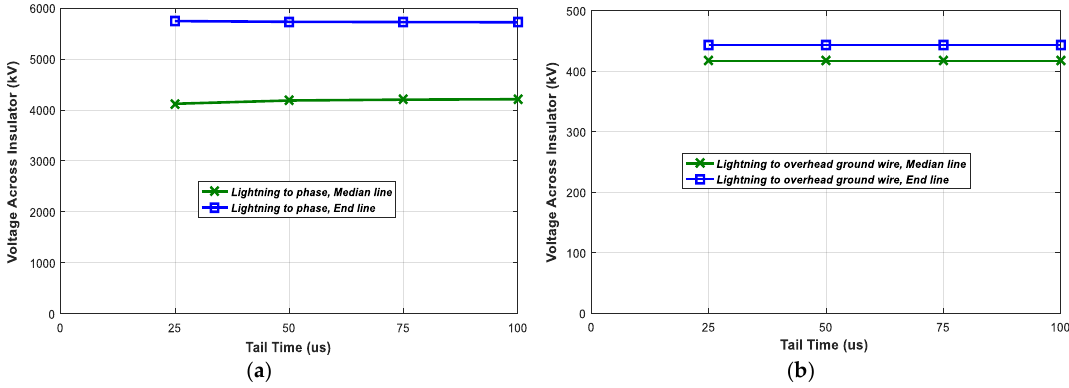
Figure 12. Voltage across the insulator for different tail time lightning current wave shapes (grounding distance of overhead ground wire = 200 m, lightning current = 40 kA, ground resistance = 10 Ω, front time = 4.12 μs); ( a ) Strike to the phase conductor; ( b ) Strike to the overhead ground wire. When Surge Arresters are Installed